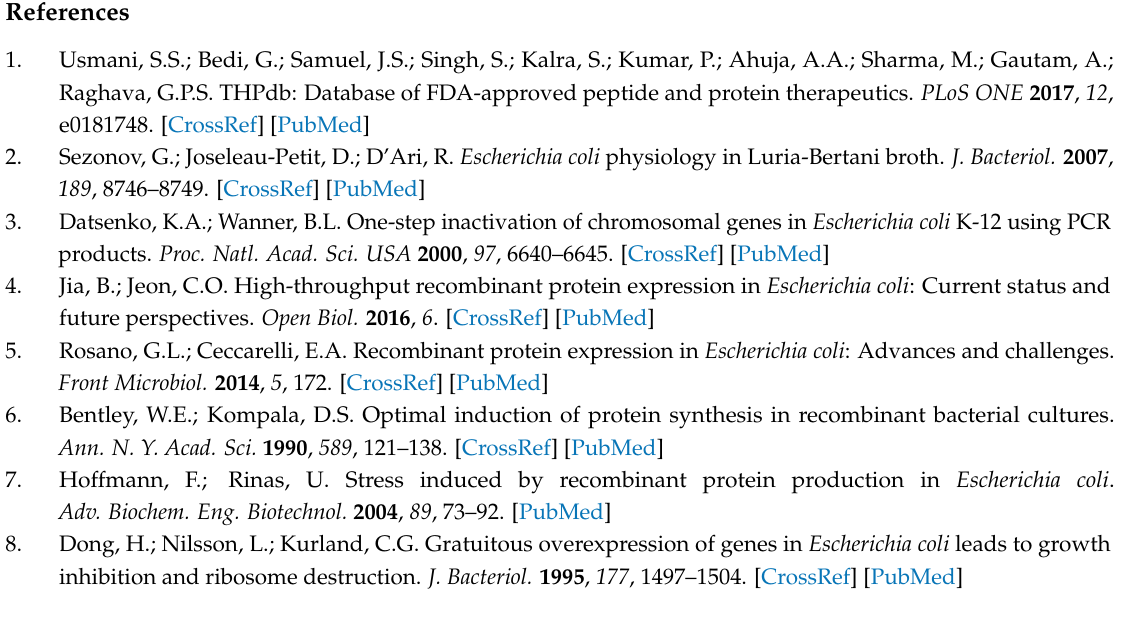
Figure S1. The delay factors of selected strains with average BCAA abundance. Figure S2. Gene ontology of all E. coli K12 genes. Table S1 . The complete list of delay factors for the ASKA collection. Table S2 . The list of amino acid compositions of proteins overexpressed in strains with severe growth effects. Table S3 . The list of rare codon abundances in proteins overexpressed in strains with severe growth